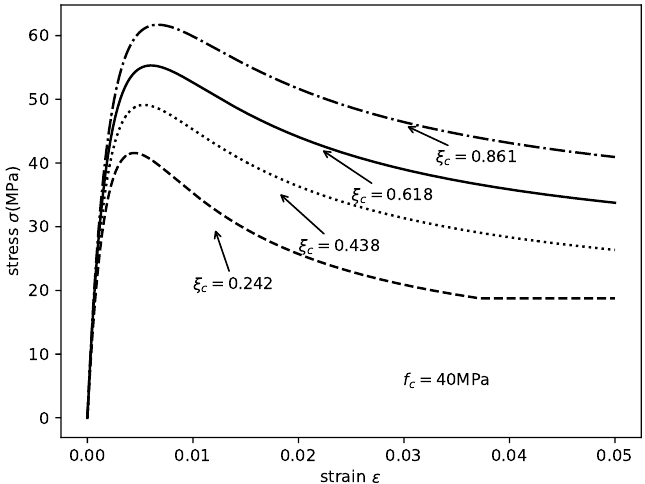
Figure 4. Stress–strain relationships of steel tube confined